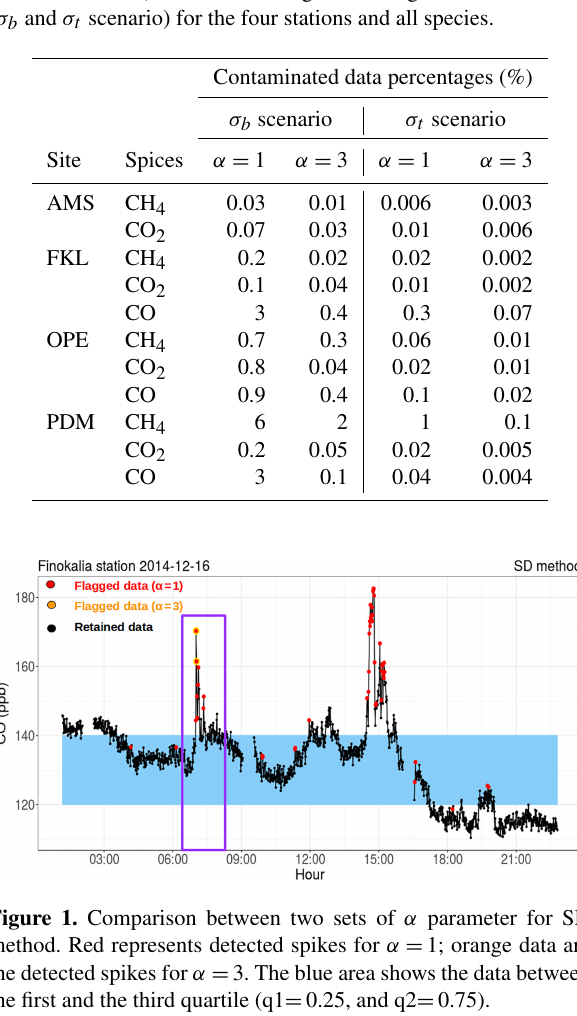
Table 2. Sensitivity of SD method spike detection for two sets of α ( α = 1 and α = 3) and for two ranges of background data interval ( σ b and σ t scenario) for the four stations and all species.